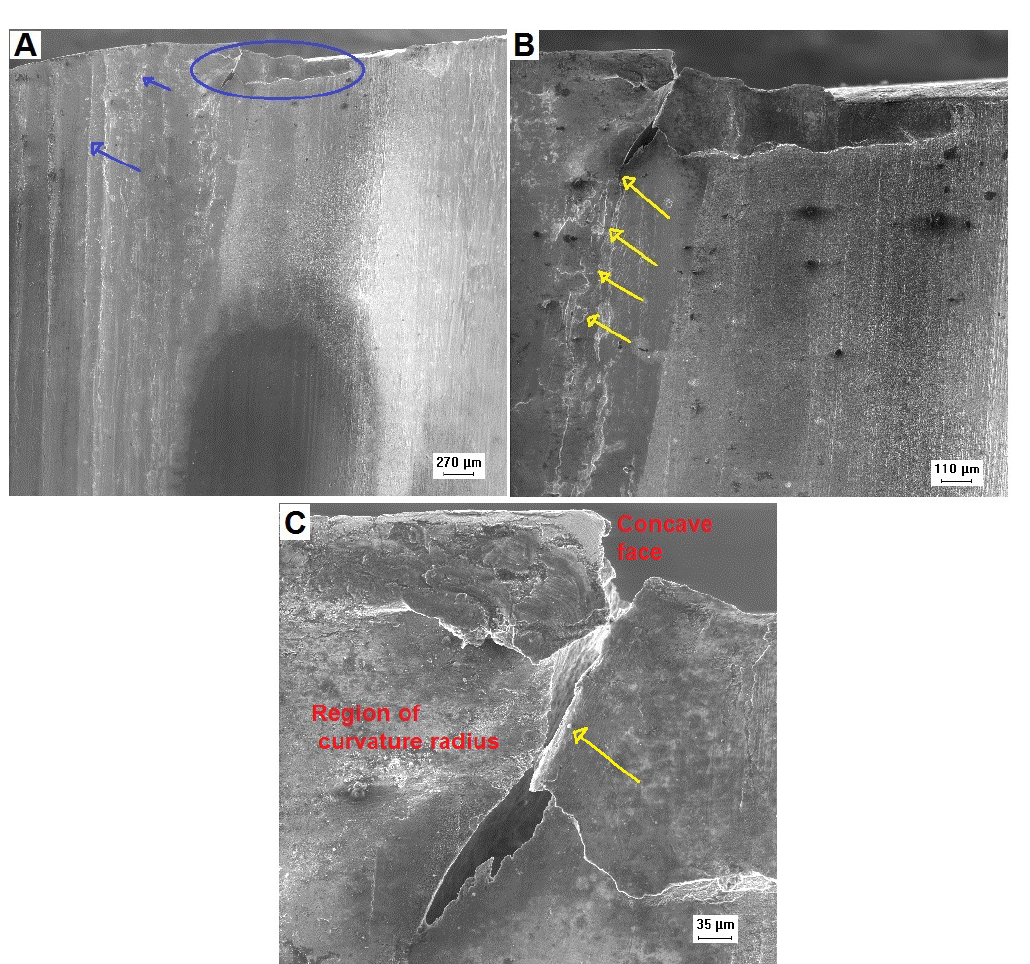
Figure 15. SEM images of the fracture surface of the P1 blade. (A) Localized material loss (blue ellipse) and plastically deformed areas (green arrow). (B) Fretting fatigue crack (yellow arrows). (C) Higher magnification of the previous image evidencing the fretting fatigue crack (yellow arrow).